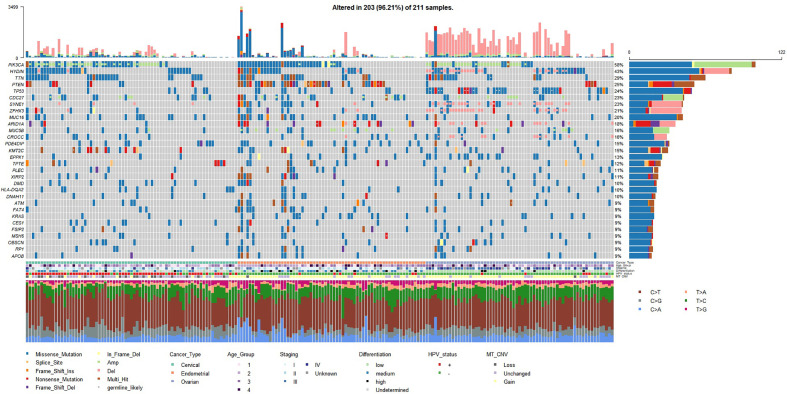
Mutation landscape represented by top 30 frequently mutated genes (small-scale mutations + copy number variations) in the studied gynecologic cancer cohort (n=209). Both small-scale mutations and CNV (Amp/Del) were taken into account. Annotations include cancer type of each sample, age groups (age < 45 - group 1; 45 ≤ age < 55 - group2; 55 ≤ age < 65 - group 3; age ≥ 65 - group 4), TNM overall staging, tumor cell differentiation status, HPV status, and mitochondrial copy number variation (MT_CNV). Likely germline mutations are highlighted with white dots.